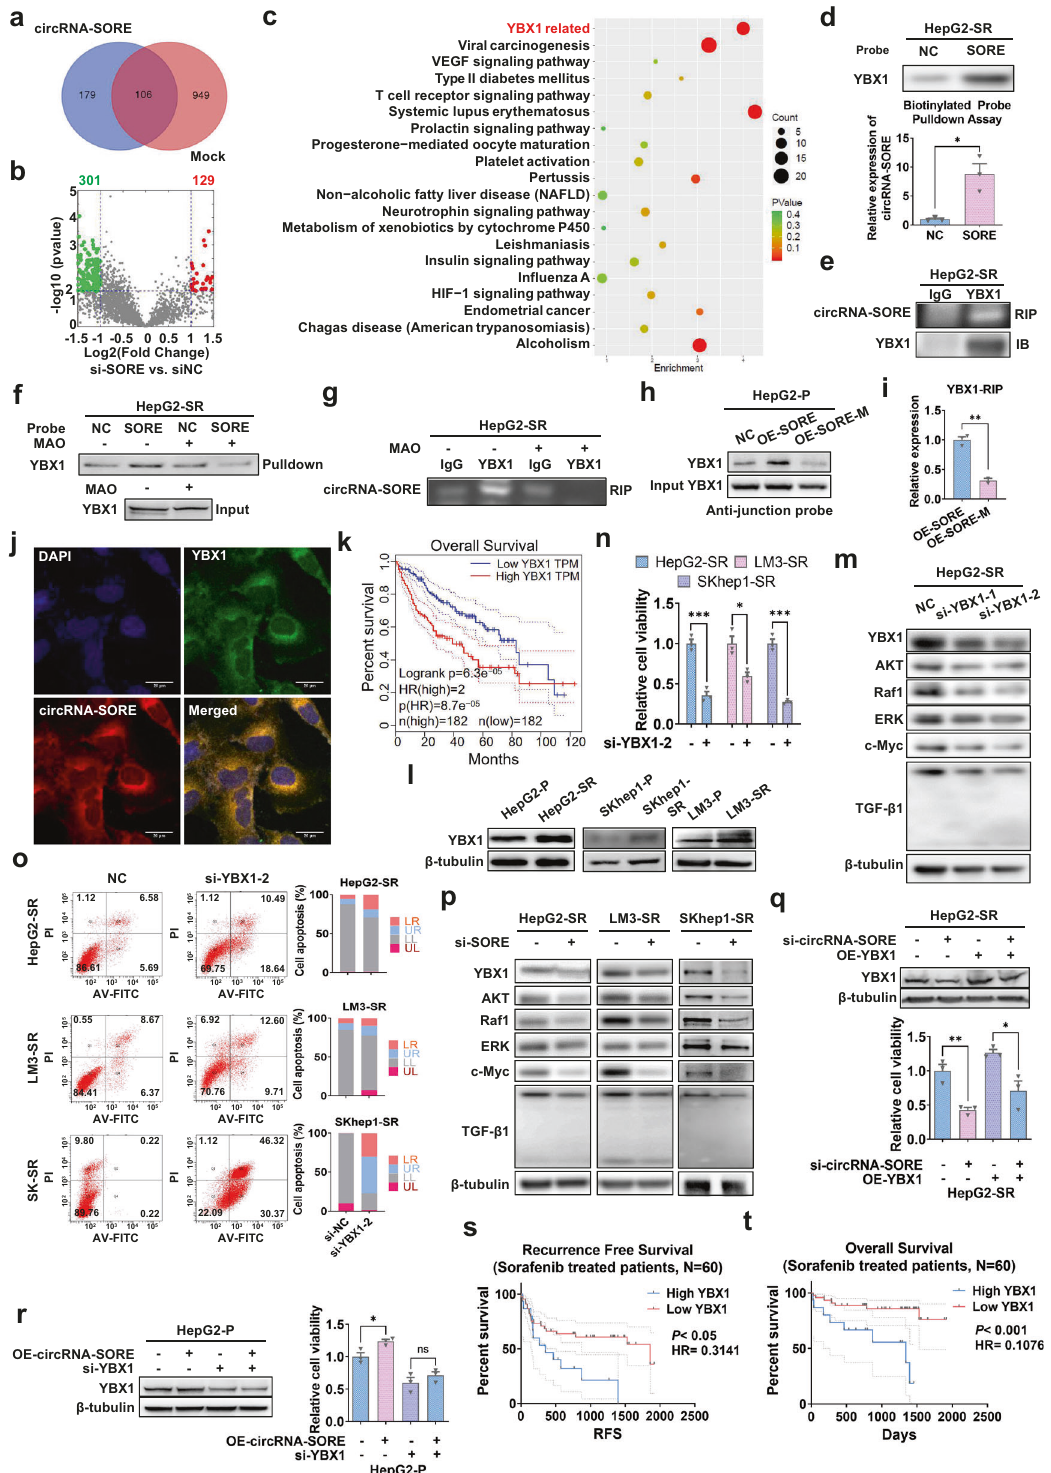
PRP19 and YBX1, whereas overexpression of the mutant circRNA-SORE had no effect (Fig. 4r). Based on these results, we proposed a model in which circRNA-SORE binds to YBX1 in the cytoplasm, thus preventing YBX1 from translocating to the nucleus to interact with and subsequently be degraded by PRP19 (Fig.